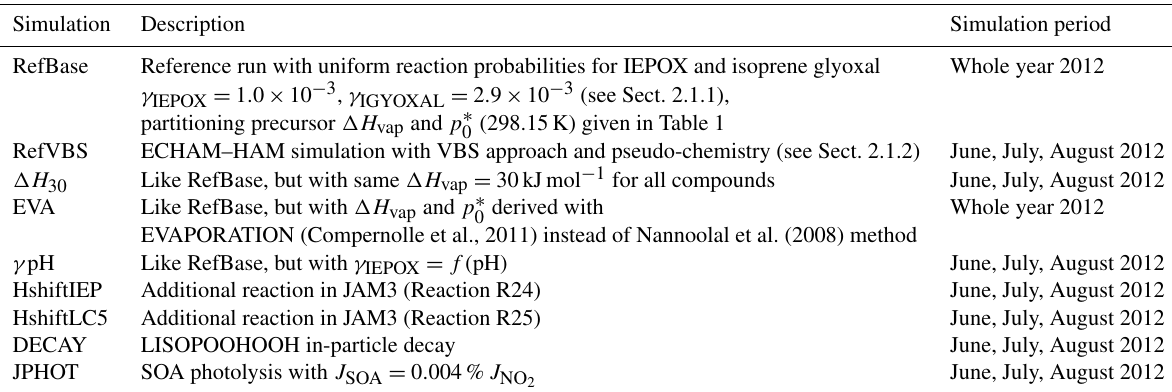
Table 2. Description of simulations performed. Simulation Description Simulation period RefBase Reference run with uniform reaction probabilities for IEPOX and isoprene glyoxal Whole year